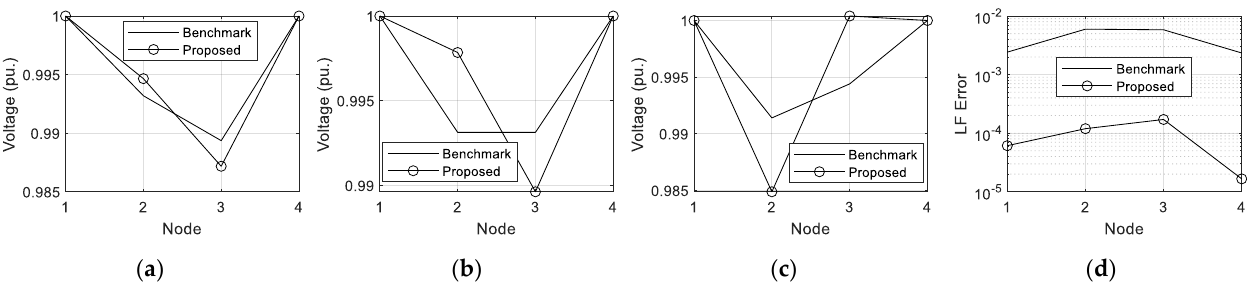
Table 6. The details of PV nodes.